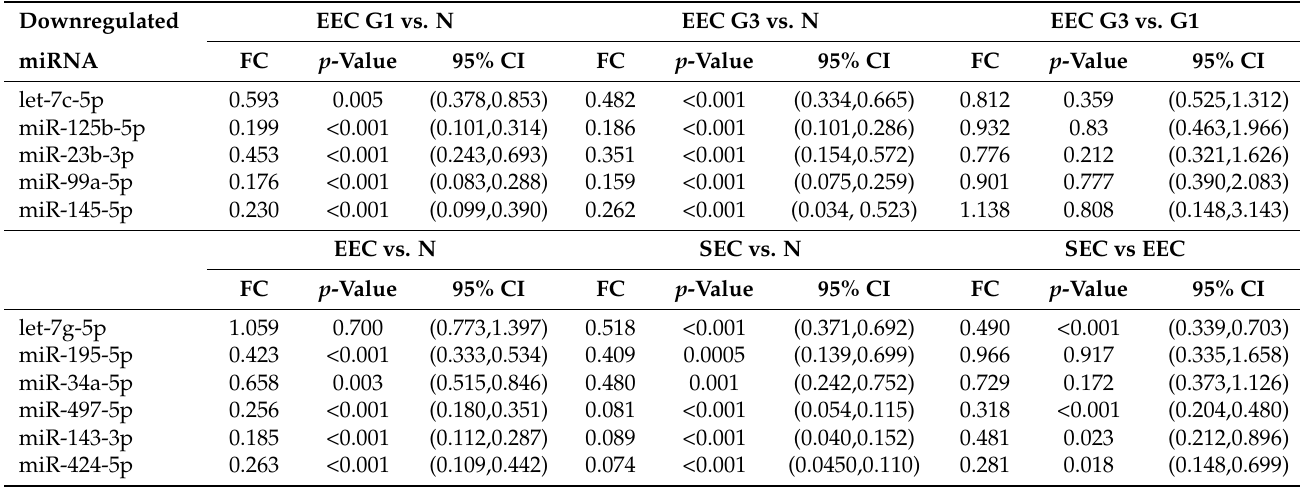
Table 1. Verification of expression differences in selected miRNAs when comparing different subtypes of endometrial